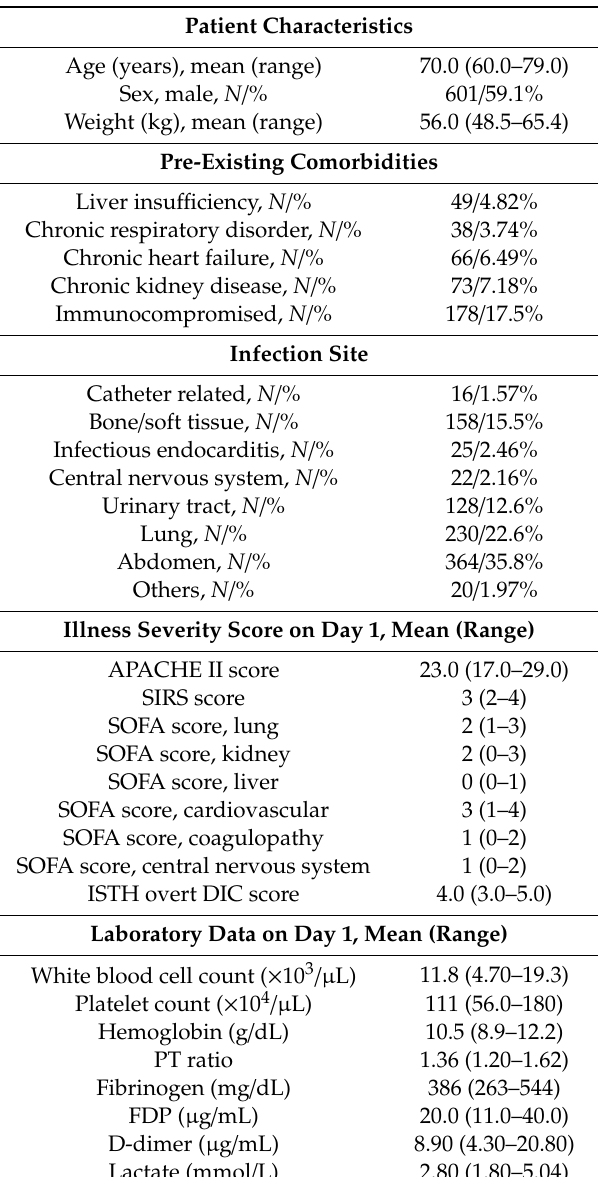
Table 1. Baseline characteristics of all patients ( N =